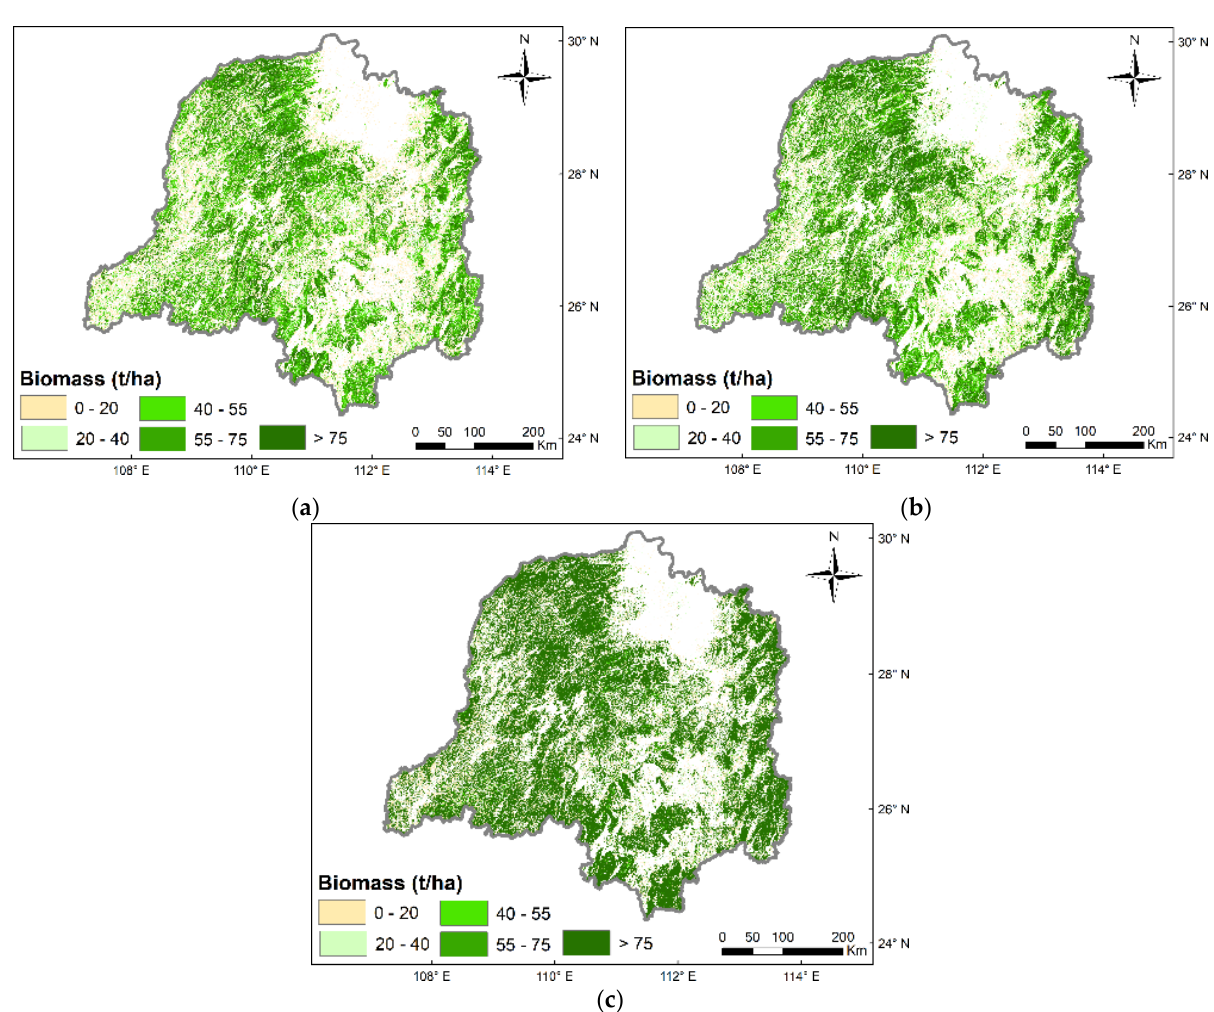
Figure 3. Biomass of forest and shrub. ( a ) Biomass of the year 2000; ( b ) biomass of the year 2010; ( c ) biomass of the year